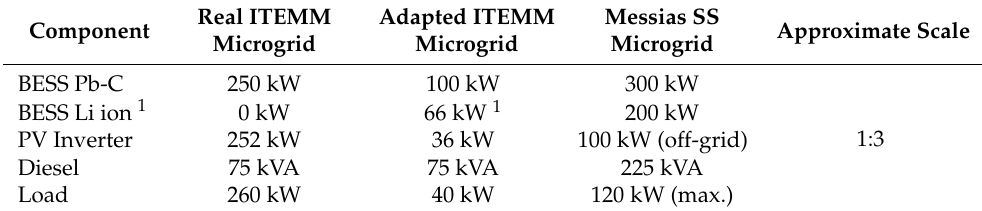
Table 4. The approximate scale between ITEMM and Messias SS microgrids.